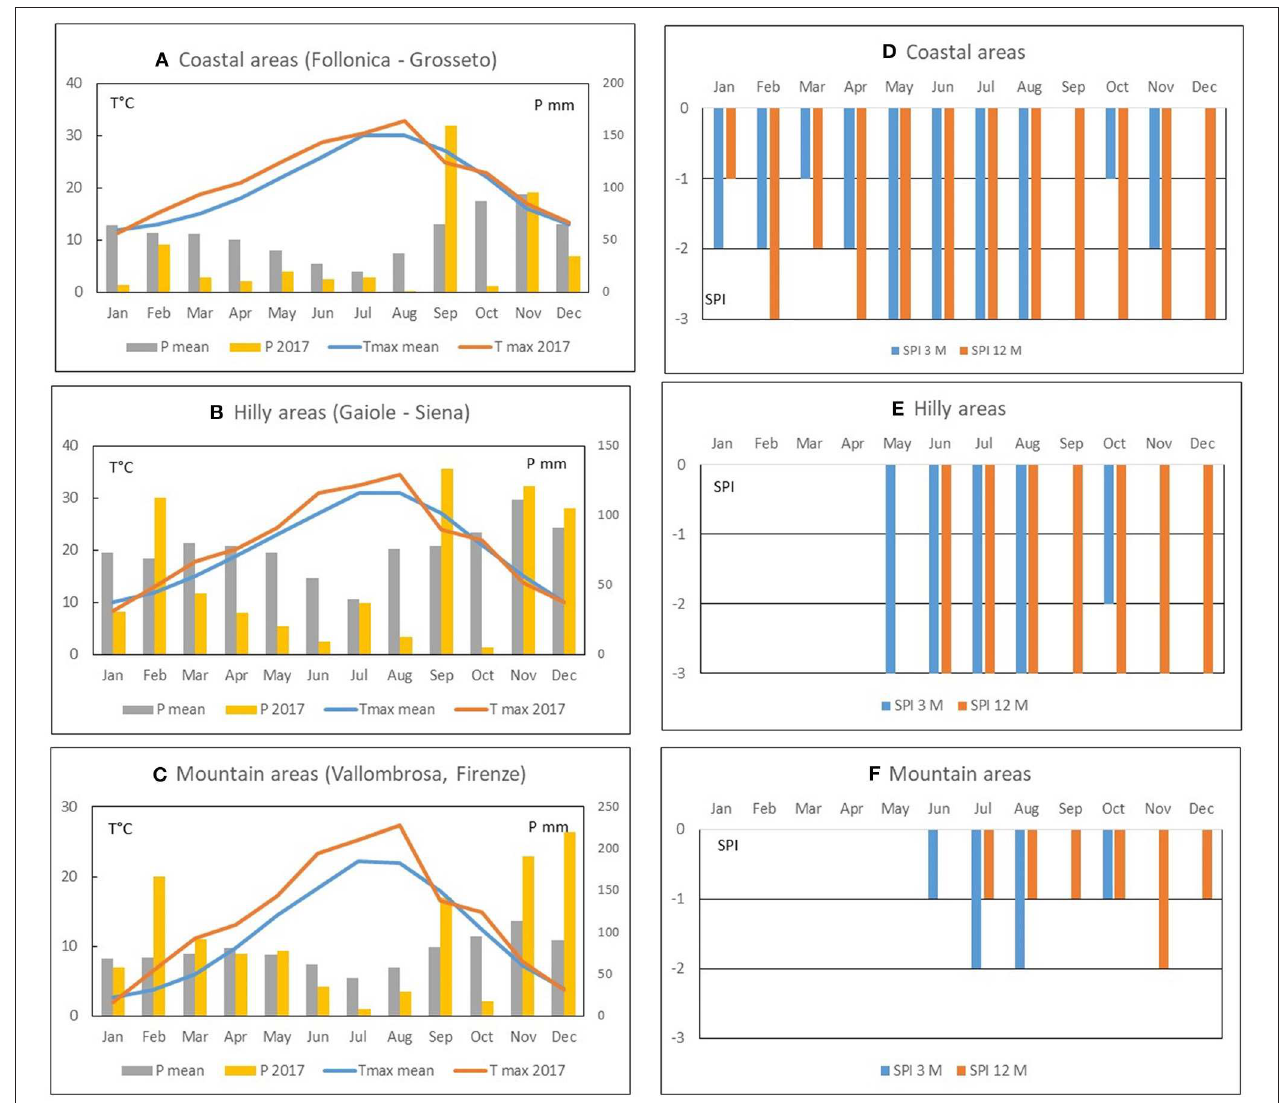
FIGURE 1 | Left: Annual pattern of monthly precipitations (Pmm, total monthly, columns) and temperatures (T ◦ C, mean of daily maximum, lines) in coastal (A) , hilly (B) , and mountain (C) areas of Tuscany. P and T are presented as average of the last 30 years (mean) and as values of the critical year (2017). The data were collected from http://www.sir.toscana.it/ricerca-dati. Right: Annual pattern (2017) of SPI (Standardized Precipitation Index) in coastal (D) , hilly (E) , and mountain (F) areas of Tuscany. SPI is reported for short (3 months) and long (12 months) periods. Negative values indicate drought conditions. The scale indicates moderate ( − 1), severe ( − 2), and extreme ( − 3) drought. Absence of anomalies is indicated with 0 (no bar). The data were collected from: http://www.lamma.rete.toscana.it/archivio-bollettini-siccit.